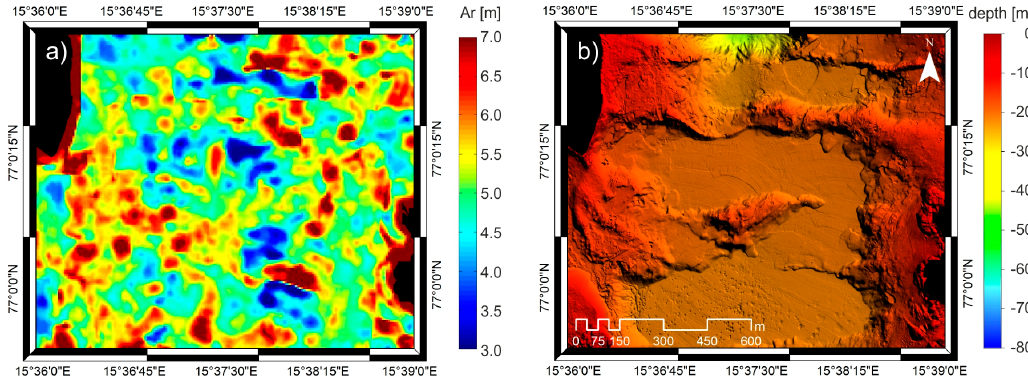
Figure 9. Detailed maps of the bottom of Isbjørnhamna and Hansbukta Bays in the Hornsund Fjord, which compare the autocorrelation length (a parameter describing the terrain roughness with a spatial scale in the range of 1–49 m, for DEM with a step of d = 0.5 m in the moving window with a side length of 70 m and 90% overlapping) and the bathymetry of the area; ( a ) value of the autocorrelation length and ( b ) seafloor morphology in the place with characteristic tongues of underwater mudslides and pockmarks.